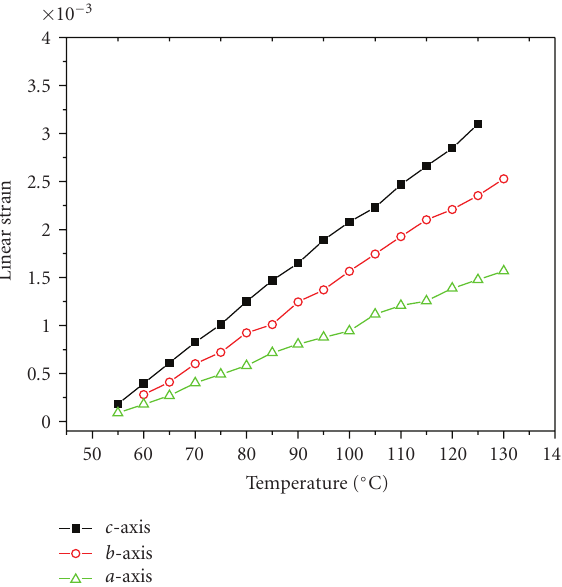
Figure 24: Anisotropy of linear strain along the three